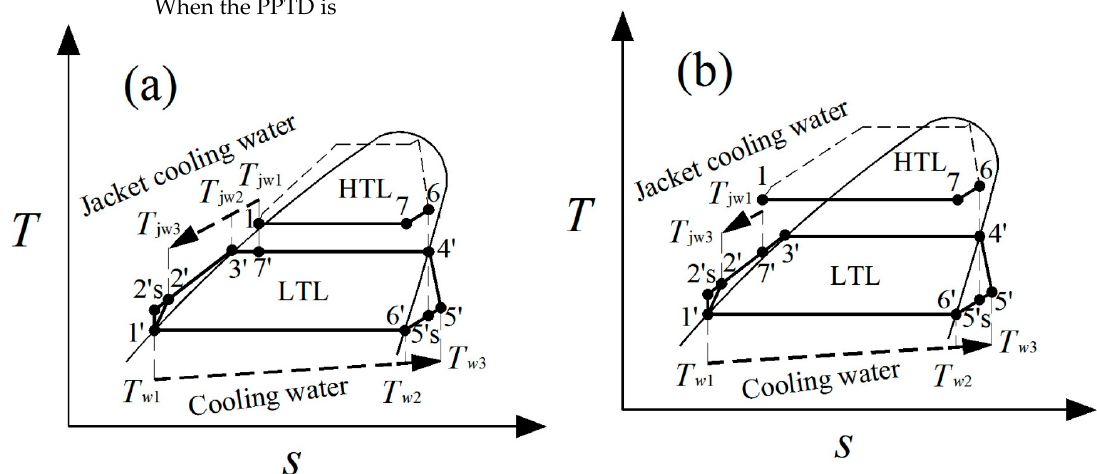
Figure 3. Low-temperature loop (LTL) T - s diagram: ( a ) Case 1 ( T 3' + T pp2 ≤ T jw1 ); ( b ) Case 2 ( T 3' + T pp2 > T jw1 ).